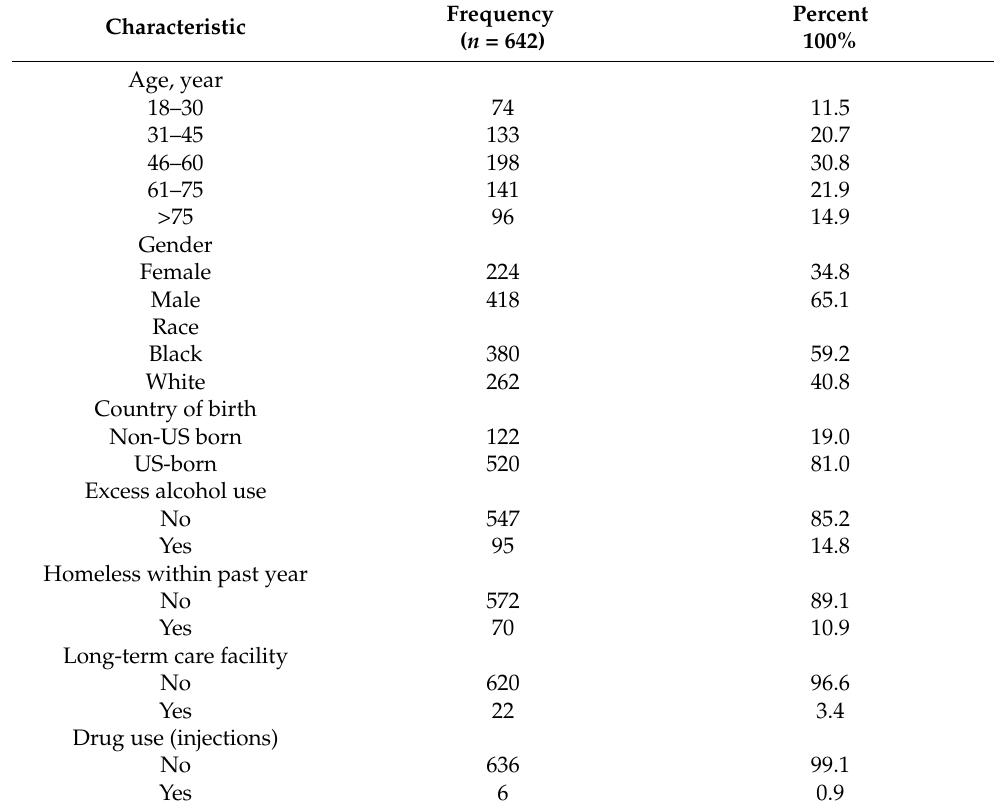
Table 1. Sociodemographic characteristics of tuberculosis cases in Mississippi in